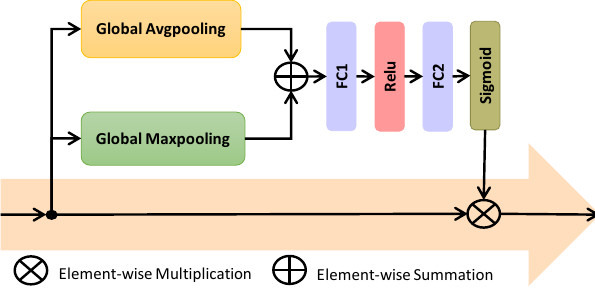
Figure 2. Channel attention